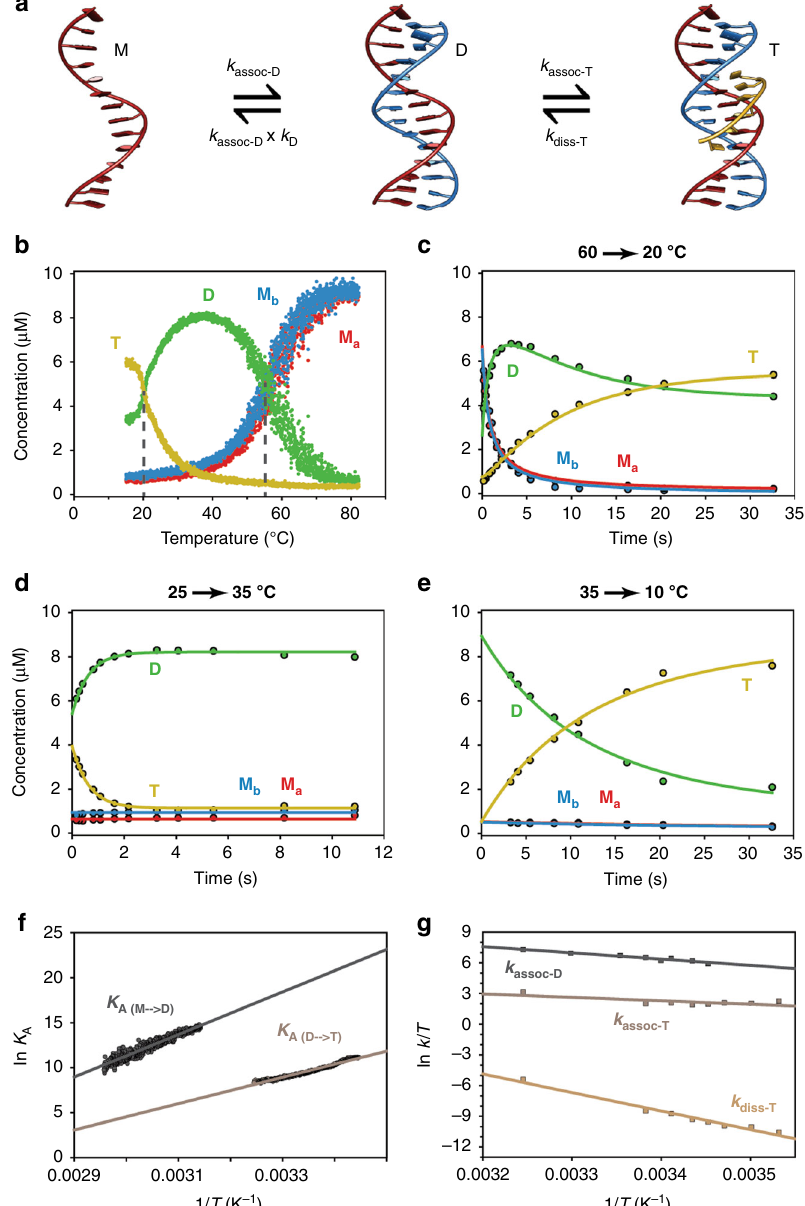
Fig. 4 Thermal denaturation and kinetics of folding and unfolding of a DNA triplex. a Representation of the chemical equilibrium of formation of a DNA triplex. b Thermal denaturation experiment of a DNA triplex monitored by native MS (10 µ M M a , 10 µ M M b , and 30 µ M M c in 100 mM TMAA at pH 5.5). c – e Kinetics of triplex formation monitored using T -jump ESI-MS, using jumps from from 60 to 20 °C, 25 – 35 °C, and 35 – 10 °C, as indicated. For the kinetics, a model corresponding to the chemical equations displayed in a was fi tted to the data to obtain the rate constants. f Van ’ t Hoff plots for the formation of the duplex and the triplex. The intercept is proportional to Δ S 0 and the slope to Δ H 0 . g Eyring plot for the formation of the duplex and the formation and dissociation of the triplex. The intercept is proportional to Δ S ‡ and the slope to Δ H ‡